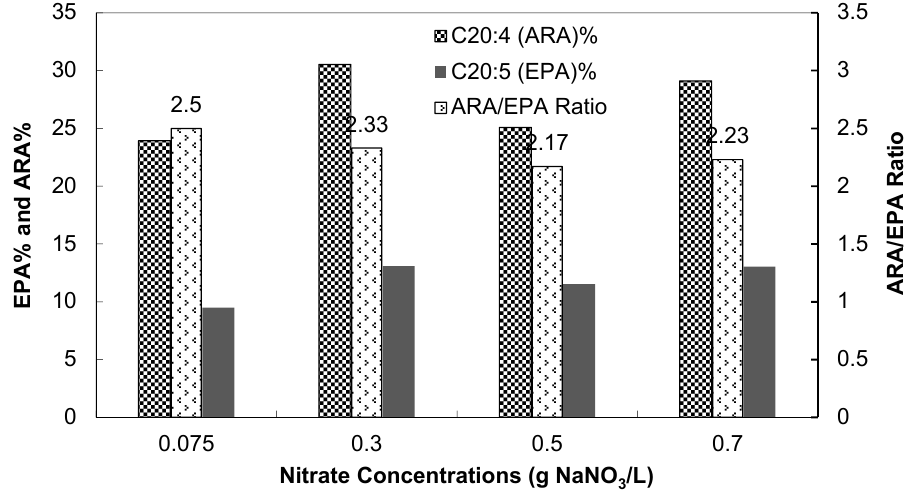
Figure 11. Effect of nitrogen level on EPA and ARA contents of P. cruentum